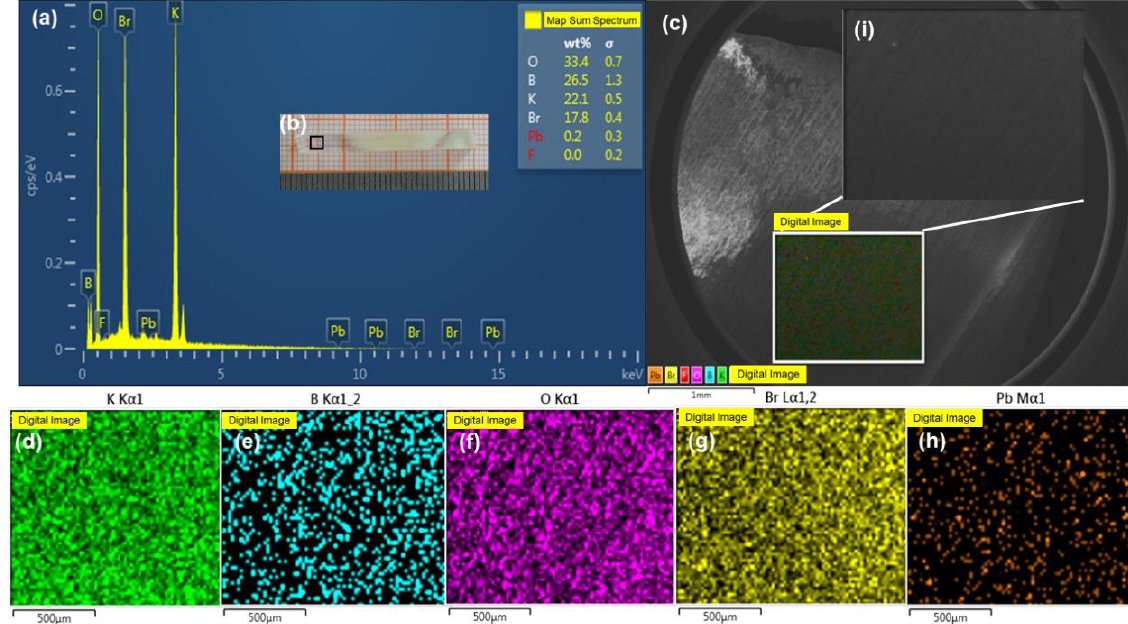
Figure 3. Element analysis of the transparent zone of KBOB-L. ( a ) Element analysis photography. ( b ) The picture of KBOB crystal ( c ) Surface topography photography. ( d – g ), and ( h ) EDS digital images of elements K, B, O, Br, and Pb, respectively. ( i ) The SEM photograph of the transparent zone of KBOB-L.